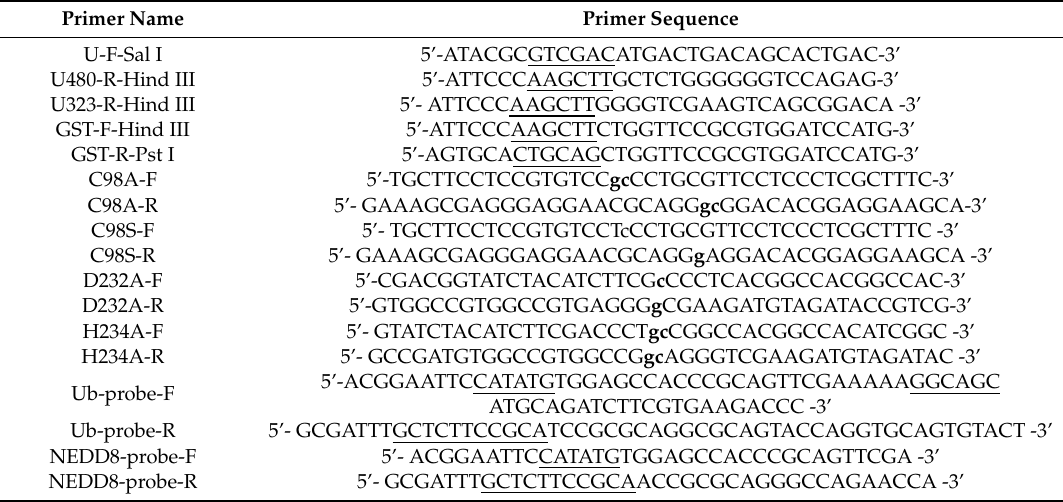
Table 2. Primers for construction and